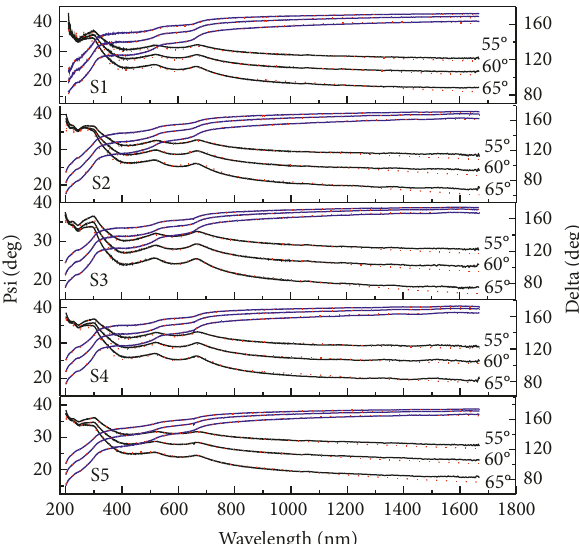
Figure 1: Experimental SE data and model fitting for five MOCVD grown InSb/GaAs samples.